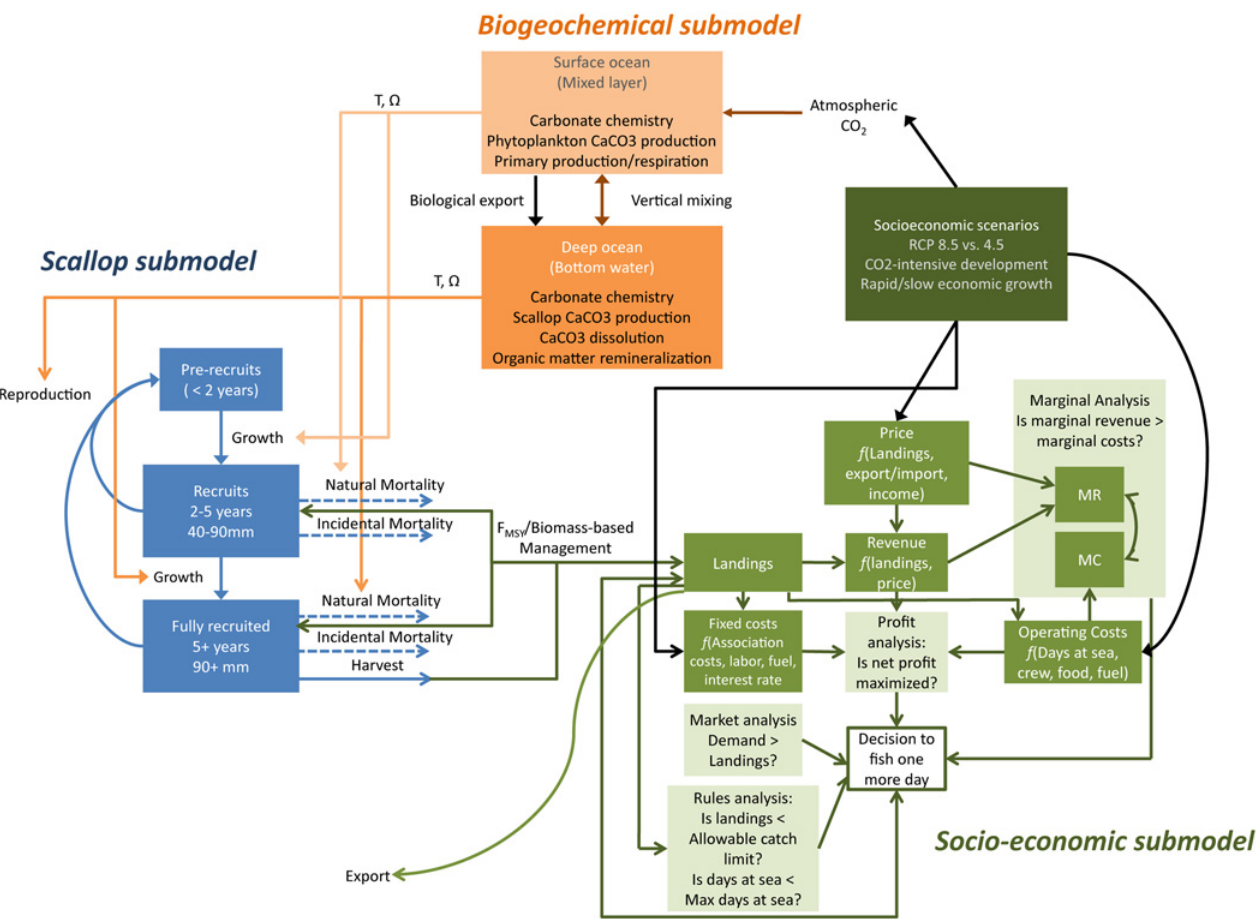
Fig 2. Schematic of IAM. Biogeochemical submodel components are orange, scallop submodel components are blue, and socioeconomic submodel components are green.